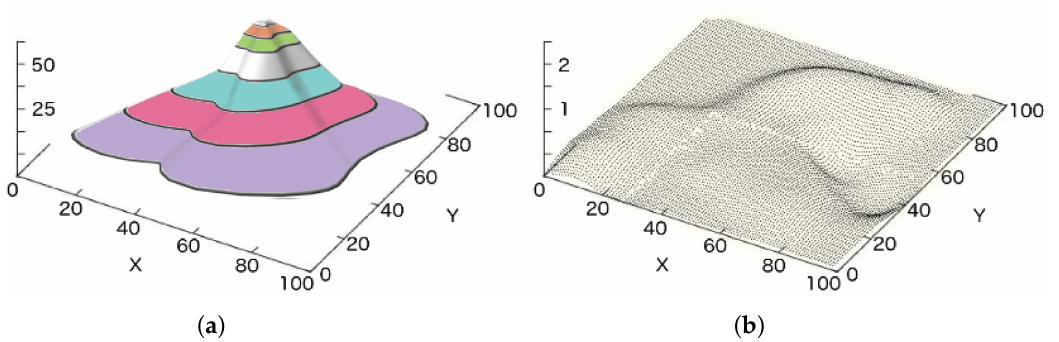
Figure 6. ( a ) The plot of a continuous elevation map with level curves, and ( b ) the plot of a DEM: for every point of the discrete domain, a discrete height value